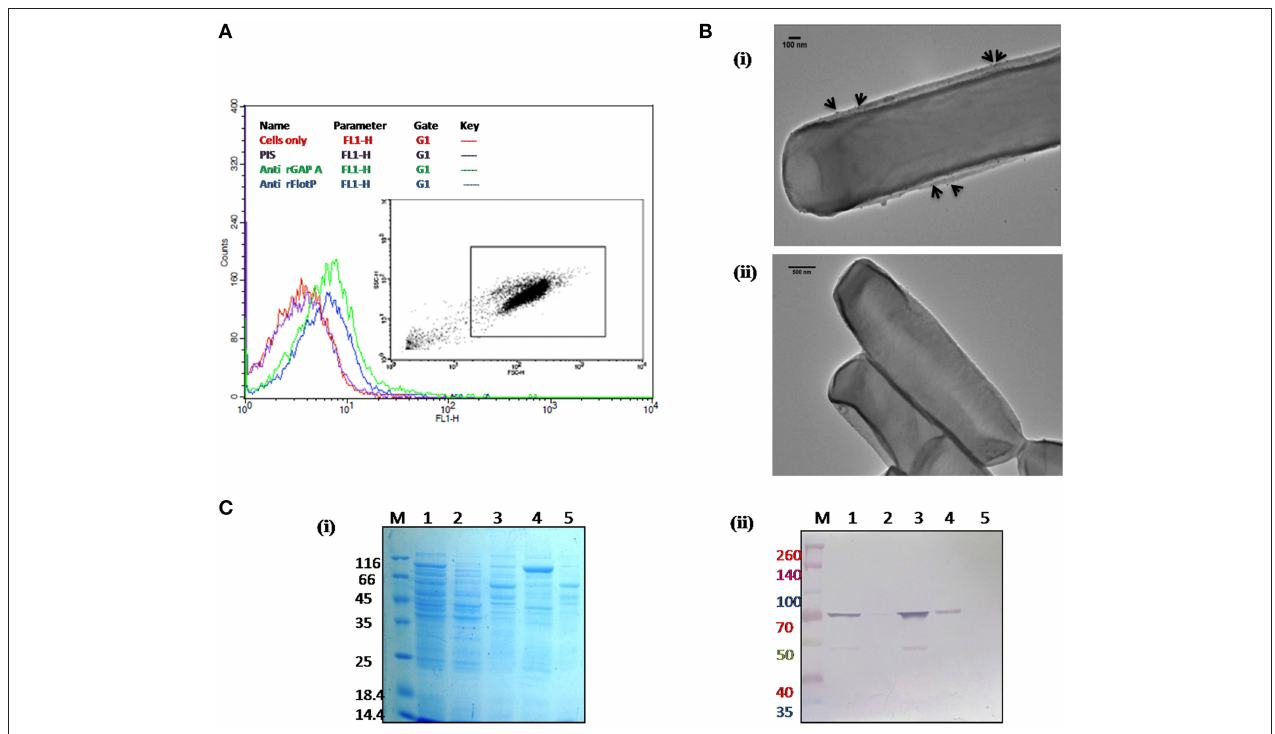
FIGURE 4 | Localization of B. anthracis FlotP. (A) Flow cytometric analysis for B. anthracis cells treated with 1:200 dilution of each anti-rFlotP IgG. anti-rGapA, Pre-immune serum, and only cells were taken as control. After staining with FITC-labeled secondary antibody (1:100), fluorescence was analyzed in FL1 and displayed as a histogram. Inset shows the gated population inside a dot plot between log of both forward scatter (size) and side scatter (granularity/shape). (B) Immunogold localization of FlotP on the membrane of B. anthracis. Whole vegetative cell of B. anthracis was used for TEM analysis. Panel (i) The black arrows indicated the gold particles around the membrane of the cell when anti-rFlotP was used as primary antibody. Images were captured at magnification of 12,000x (ii) No dots were observed when pre-immune sera was used as primary antibody. Images were captured at magnification of 6000x (C) Localization by immunoblotting. Equal amounts of proteins (3 µ g) from each fraction were loaded in respective lanes. Panel (i) indicates Coommasie stained SDS-PAGE with all fractions and panel (ii) shows immunoblotting with anti-rFlotP. Lanes: 1, cellular lysate; 2, cytosolic fraction; 3, membrane fraction after ultracentrifugation; 4, DRM; 5, DSM; and M,